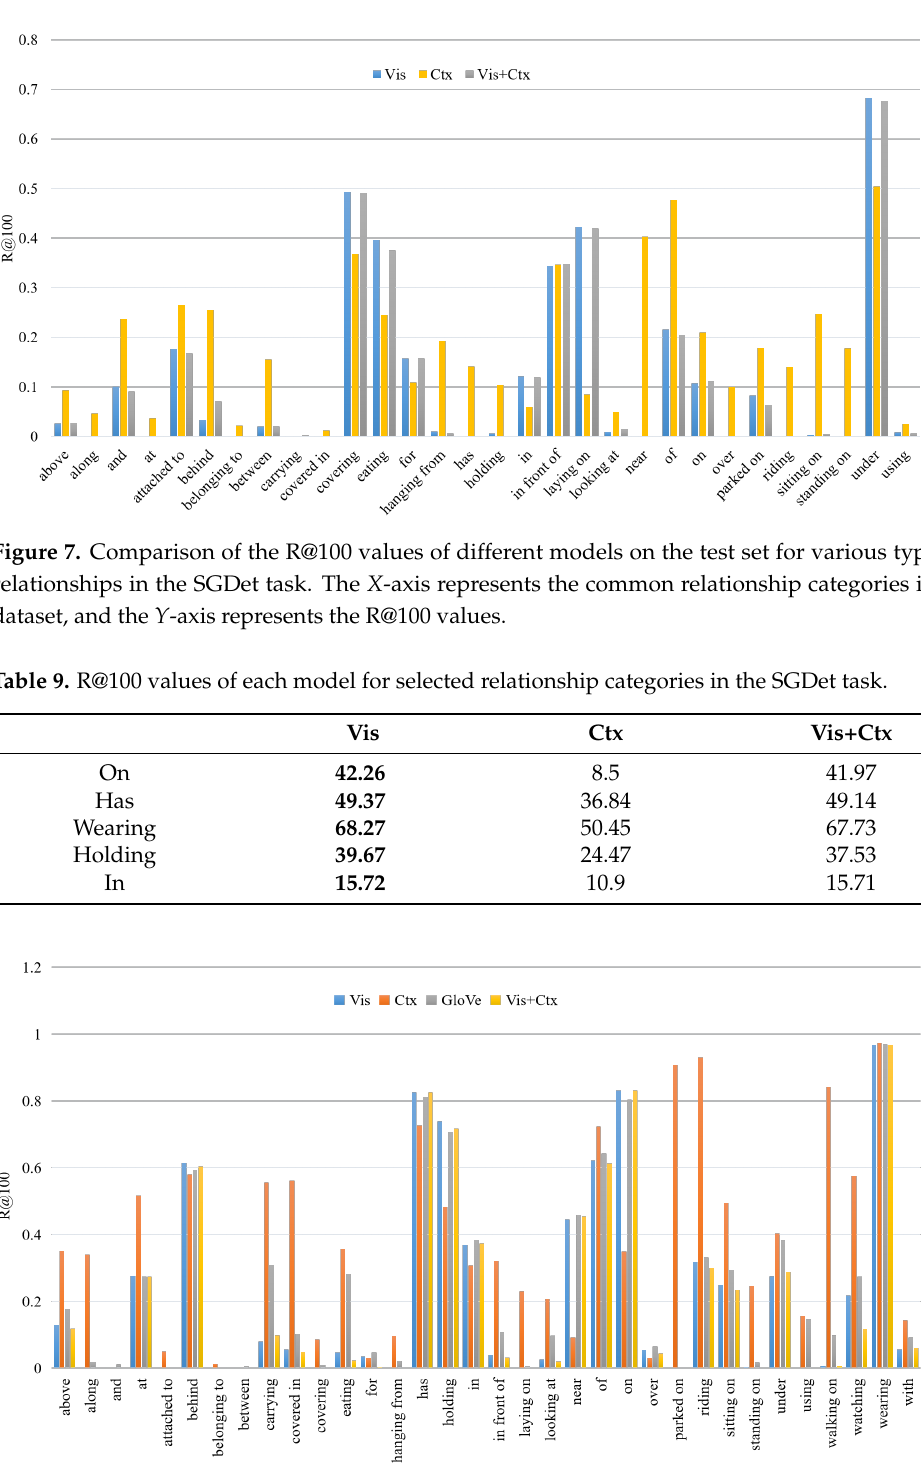
Figure 8. Comparison of the R@100 values of different models on the test set for various types of relationships in the PredCls task. The X -axis represents the common relationship categories in the dataset, and the Y -axis represents the R@100